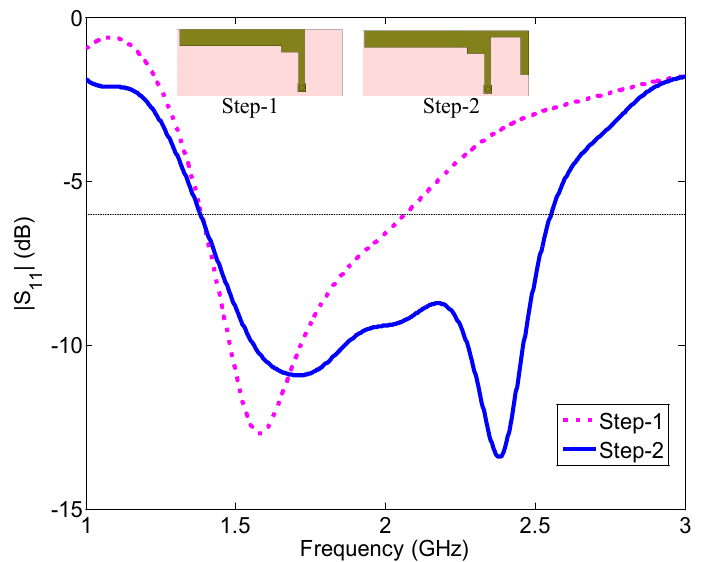
Figure 2. Two steps of the evolution of the planar antenna (Ant#1) to cover the two LSA